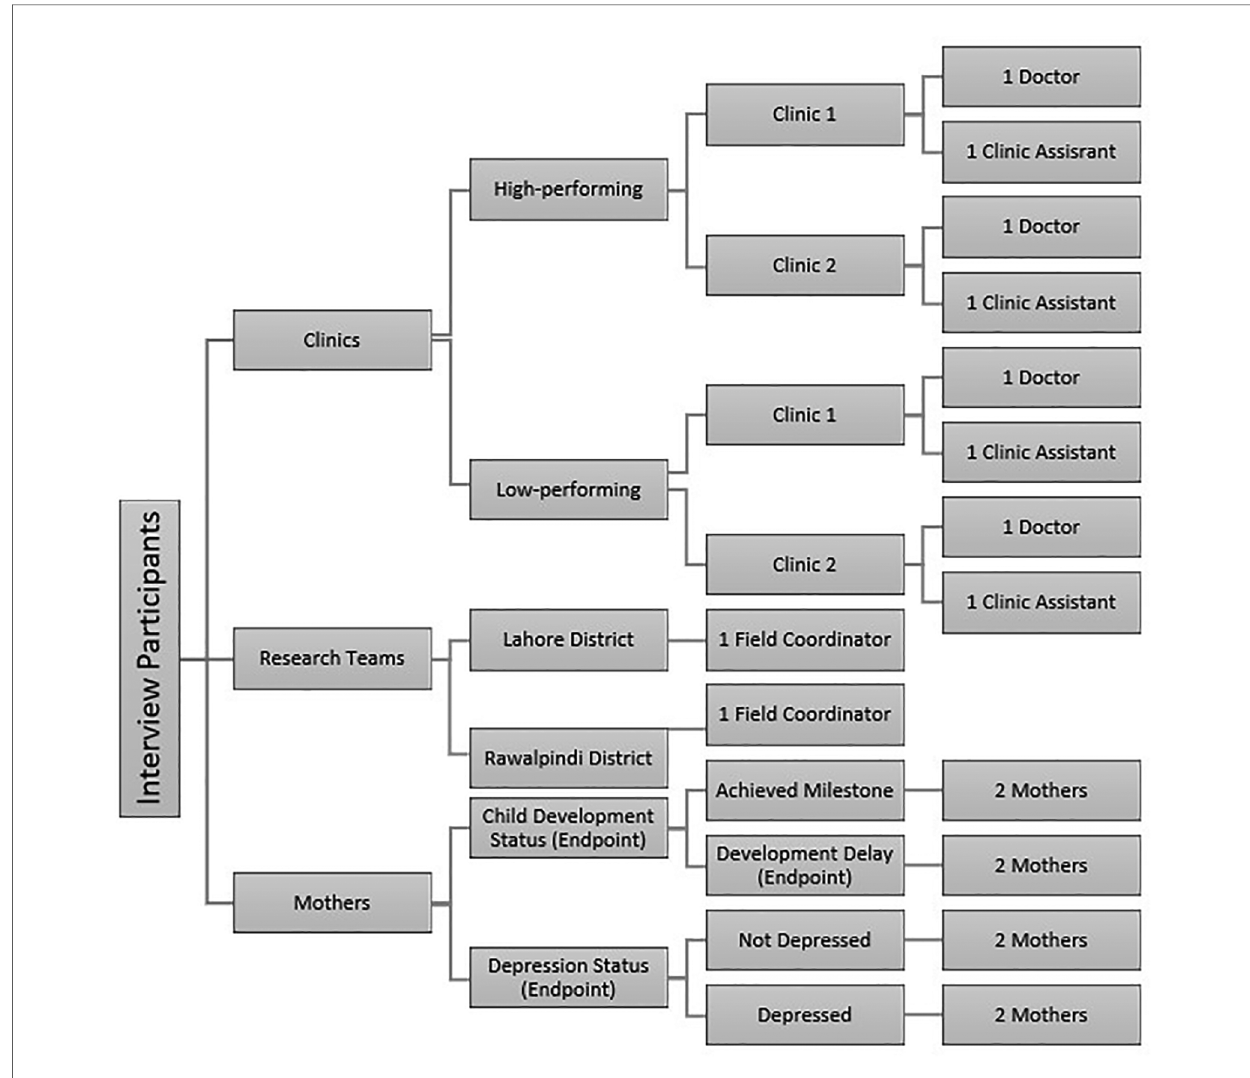
FIGURE 3 Illustrative description of interview participants [adapted from the primary outcomes process evaluation